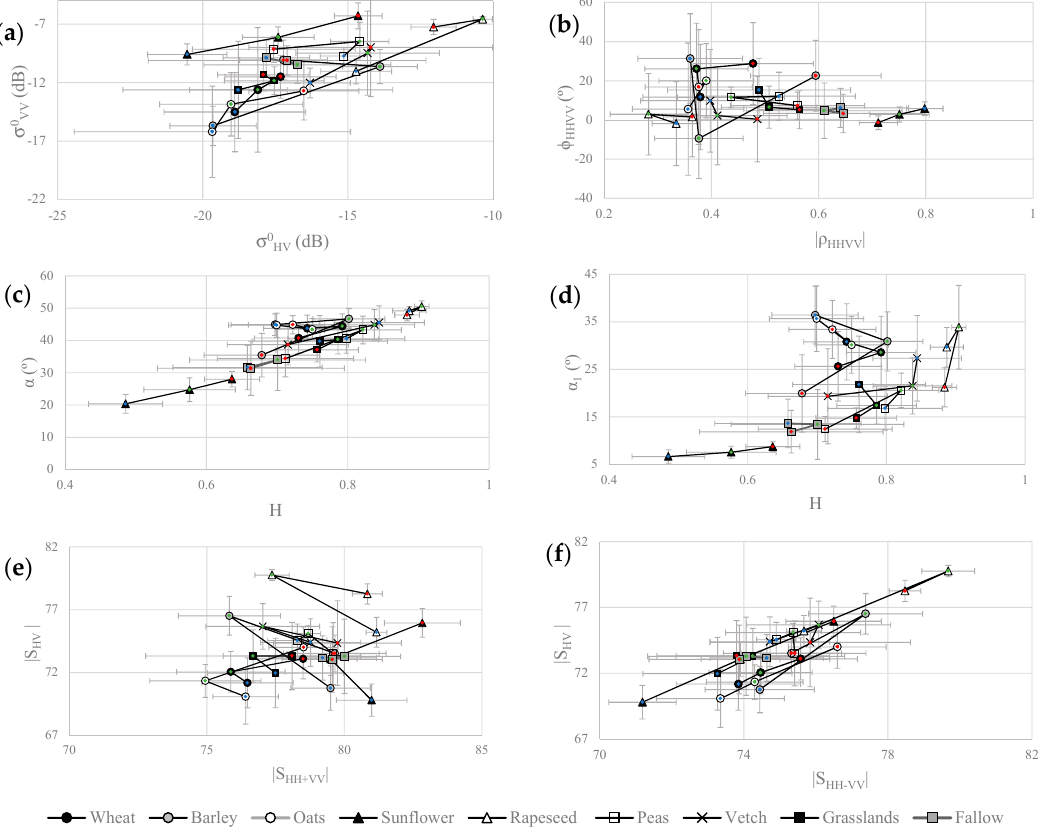
Figure 5. Different scatterplots for the three studied dates: ( a ) σ ° HV vs. σ ° VV ; ( b ) | ρ HHVV | vs. φ HHVV ; ( c ) H vs. α ; ( d ) H vs. α 1 ; ( e ) |S HH+VV | vs. |S HV |; ( f ) |S HH-VV | vs. |S HV |. Colors represent different dates, blue = 12 May 2010, green = 5 June 2010 and red = 19 June 2010. Points represent class means and error bars ±1 standard deviation.